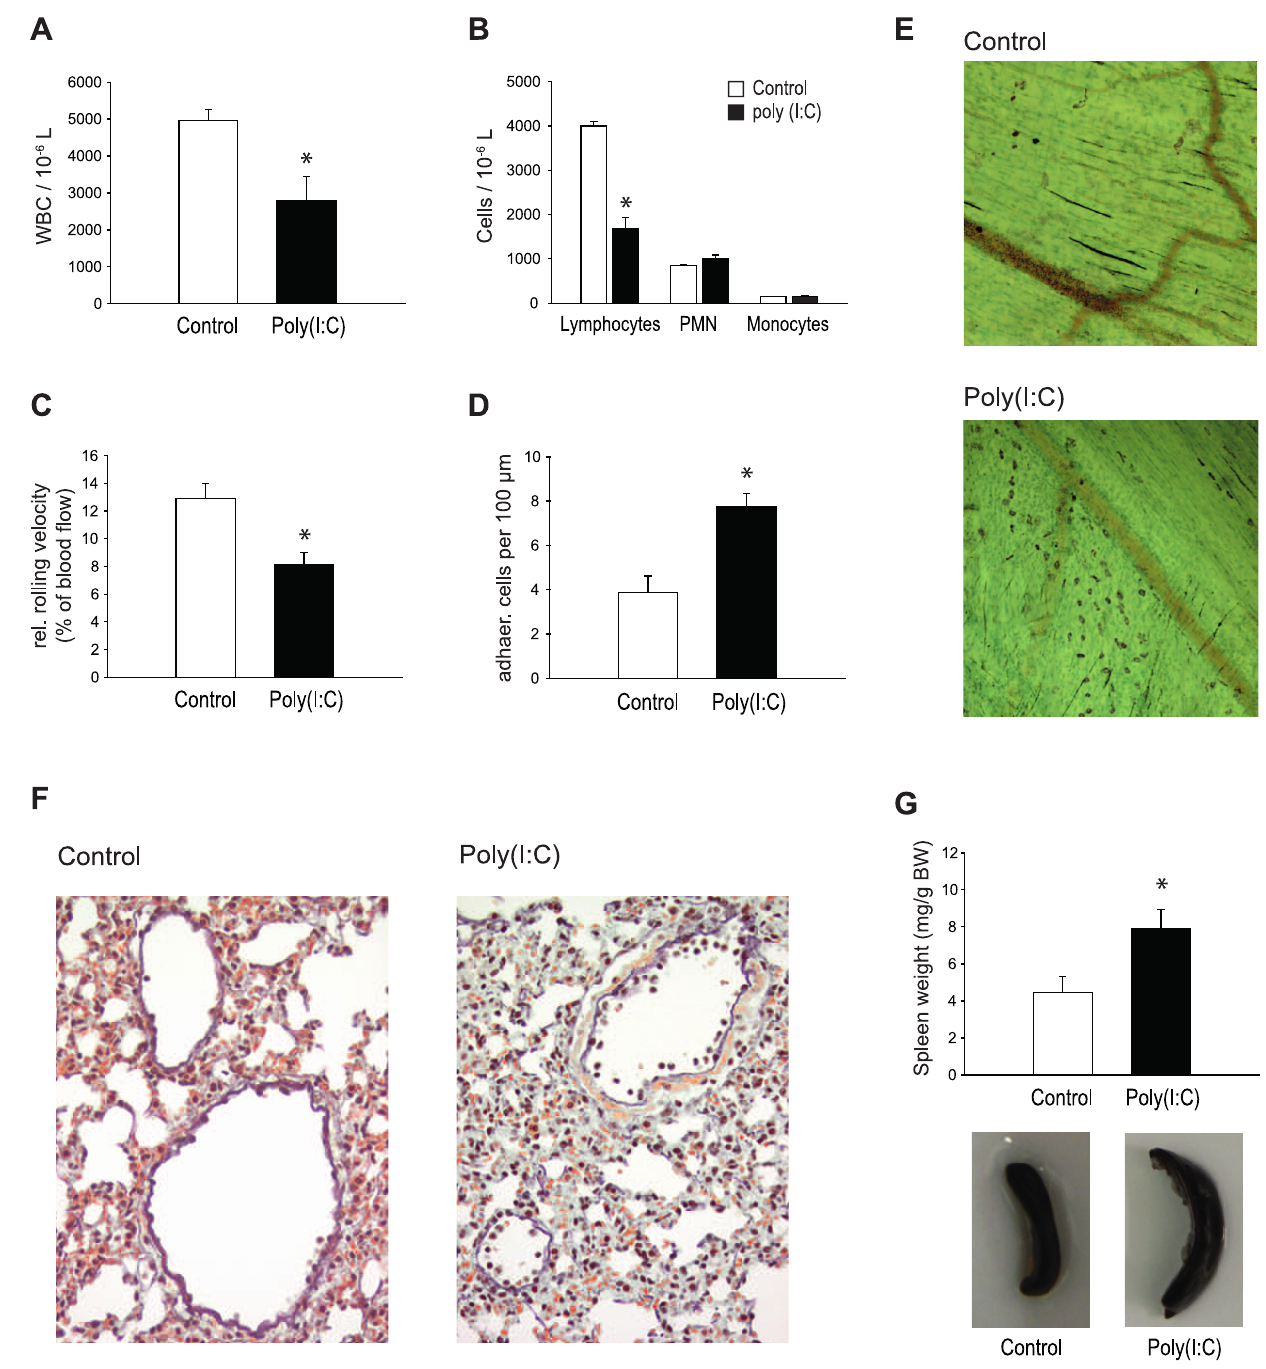
Figure 3. Effect of poly (I:C) on vascular inflammation in vivo. C57Bl/6 mice were systemically treated with poly (I:C) (200 m g i.p.) and white blood cell counts were perfomed after 48 hours (A, B). At the same time leukocyte rolling (C) and adhesion (D) in vivo as well as extravasation of leukocytes (E) were investigated in postcapillary venules of the mouse cremaster muscle by intravital microscopy or in cremaster muscle whole mounts respectively. After repeated ploly (I:C) treatment (100 m g every other day for 2 weeks) vascular inflammation was investigated in lung tissue as described (F) and spleen weight was measured (G). Results are given as means ¡ SEM (n 5 4–6 animals). Statistically significant differences to the control are depicted with * 5 p # 0.05.